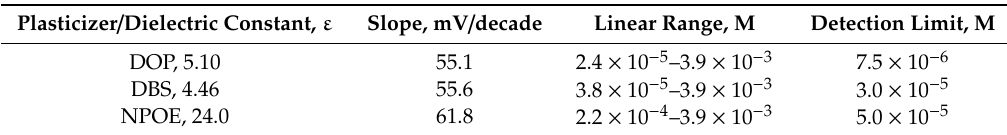
Table 2. E ff ect of plasticizers on the performance of m-chlorophenylpiperazine polymeric membrane Table 2. Effect of plasticizers on the performance of m-chlorophenylpiperazine polymeric based sensors. membrane based sensors.